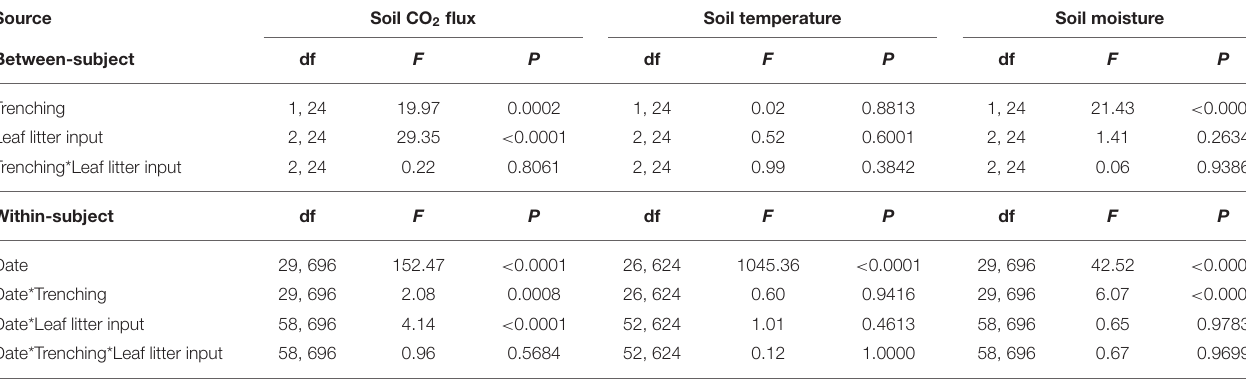
TABLE 4 | Summary of Repeated Measures Analysis of Variance (rmANOVA) for the monthly means of soil CO 2 fluxes, soil temperature, and soil moisture. Source Soil CO 2 flux Soil temperature Soil moisture